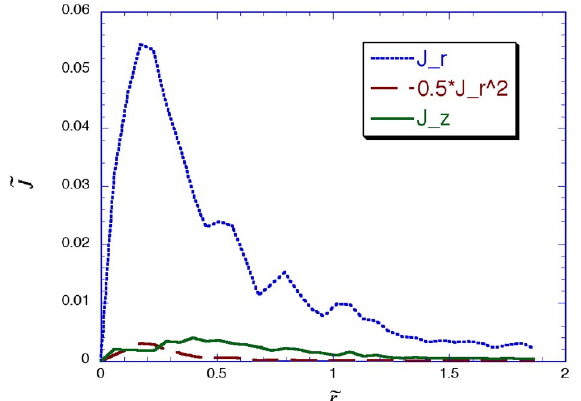
FIG. 4. (Color) Current densities just behind driving beam with ~ QQ (cid:4) 0 : 2 , uniform distribution of width ~ aa (cid:4) 0 : 2 , and length ~ ll (cid:4) 0 : 1 . Analytical prediction ~ JJ z shown.